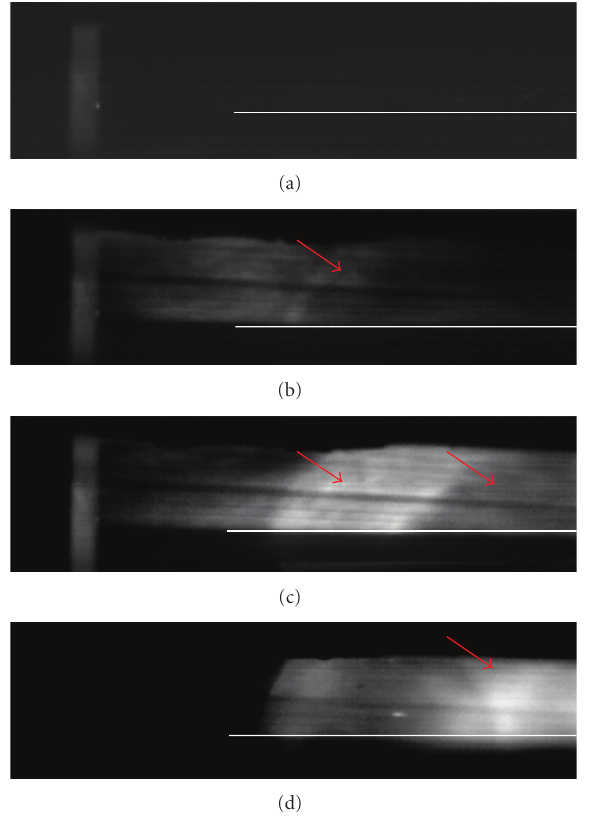
Figure 11: Snapshots of shock wave (HTPB slab @ AOA = 0 ◦ ) (a) before event ( t = 0 second), (b) shock wave arrived (dir.: → , t = 11 . 1 milliseconds), (c) shock wave arrived (dir.: → , t = 11 . 7 milliseconds), (d) ref. Shock (dir.: ← t = 14 . 3 milliseconds).